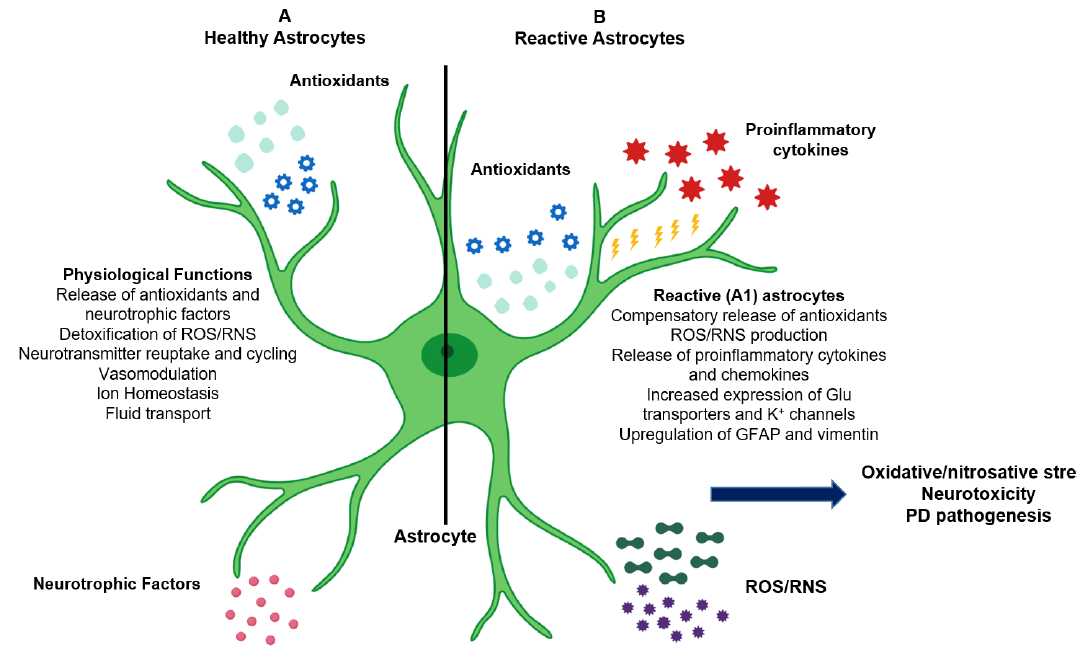
Figure1. Roleofastrocytesinthecentralnervoussystem(CNS)andinParkinson’sdisease(PD)pathogenesis. ( A ) Astrocytes provide structural and metabolic support to neurons, mediate neurotransmission and glutamate transport, and maintain ionic and vascular homeostasis. Astrocytes also secrete endogenous antioxidants (such as glutathione (GSH) and superoxide dismutase (SODs)) and neurotrophic factors into the extracellular microenvironment and are responsible for detoxification of reactive oxygen and nitrogen species (ROS / RNS) produced as byproducts of metabolism. ( B ) Reactive astrocytes produce additional antioxidants, proinflammatory cytokines and chemokines, and ROS / RNS. Chronic reactive astrogliosis leads to astrocytic oxidative / nitrosative stress, neuroinflammation, neuronal apoptosis, and PD